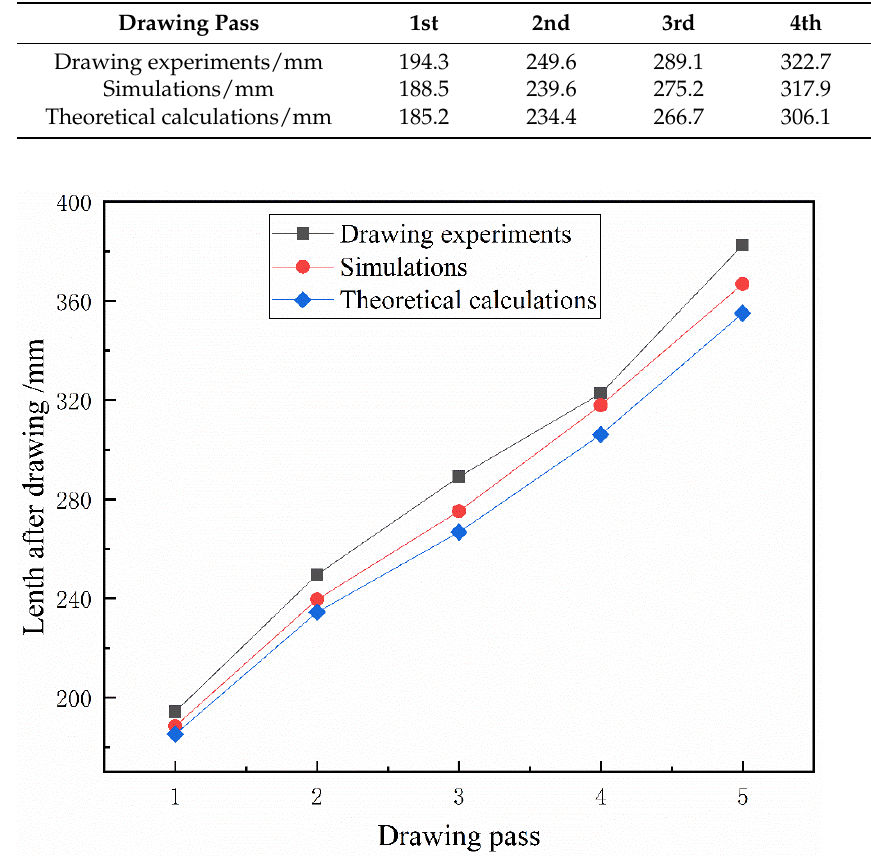
Figure 10. Comparison of length results after drawing of composite.